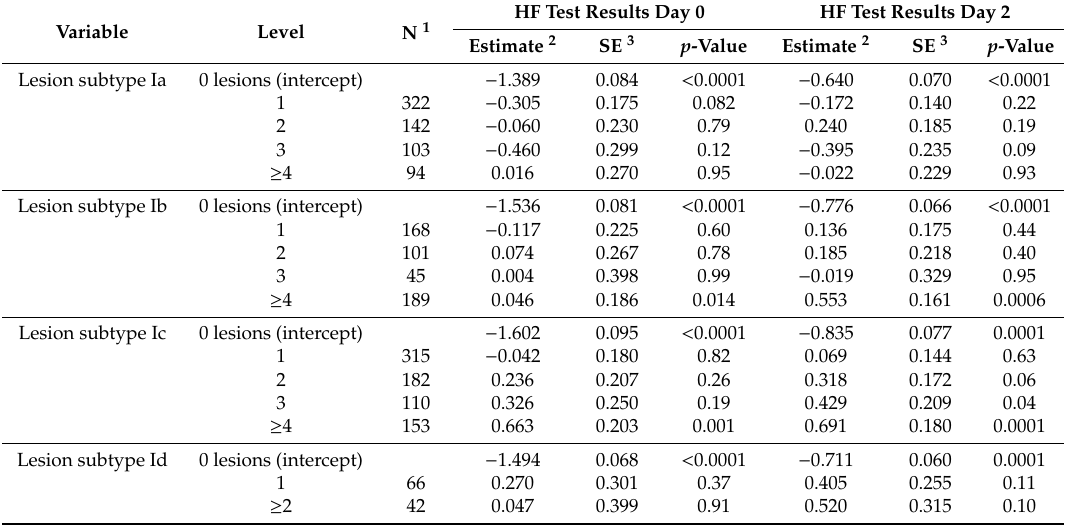
Table 5. Univariable fixed e ff ects of abomasal lesion subtype and number of abomasal lesion subtypes on the Hemo-fec ® (HF) test at Day 0 and Day 2.